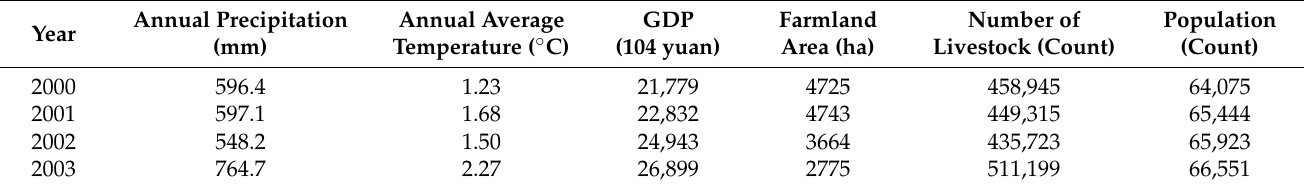
Table A1. Statistical data of Zoige County in